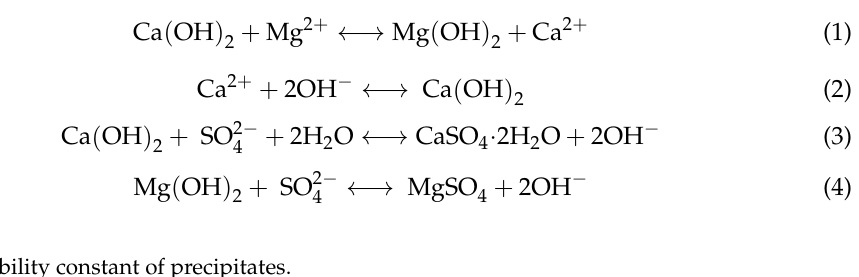
Table 1. Solubility constant of